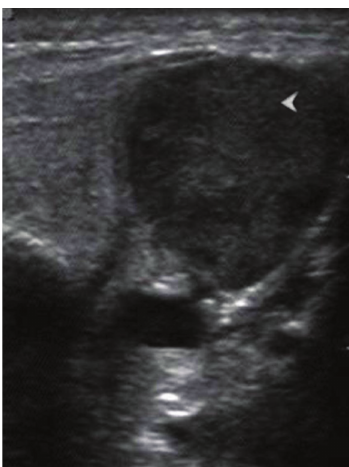
Figure 2: The left parotid. A large well-defined hypoechoic lesion (arrowhead) within the left parotid.